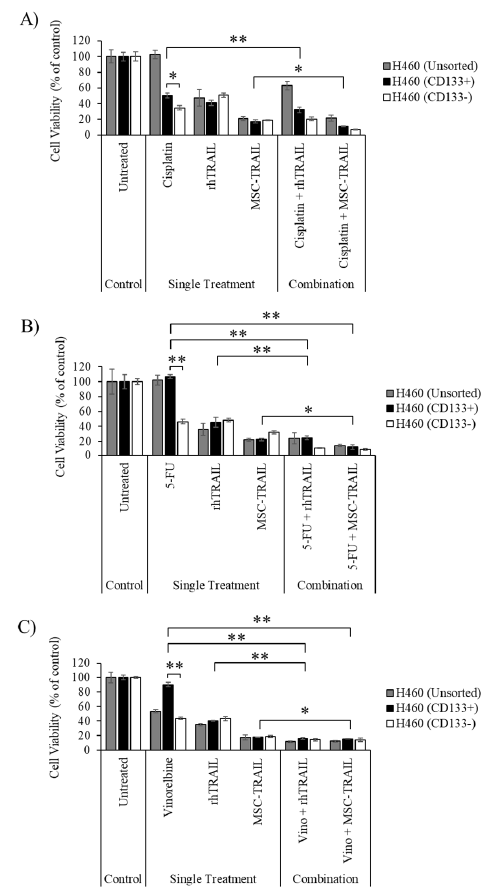
Figure 4. Cell viability of chemo-sensitized H460-derived CD133+ CSCs to MSC-TRAIL treatment. ( A ) Chemo-sensitization using cisplatin enhanced the cytotoxic effect of MSC-TRAIL, but not rhTRAIL in the H460-derived CSCs. ( B , C ) Chemo-sensitization of H460-derived CSCs using 5-FU